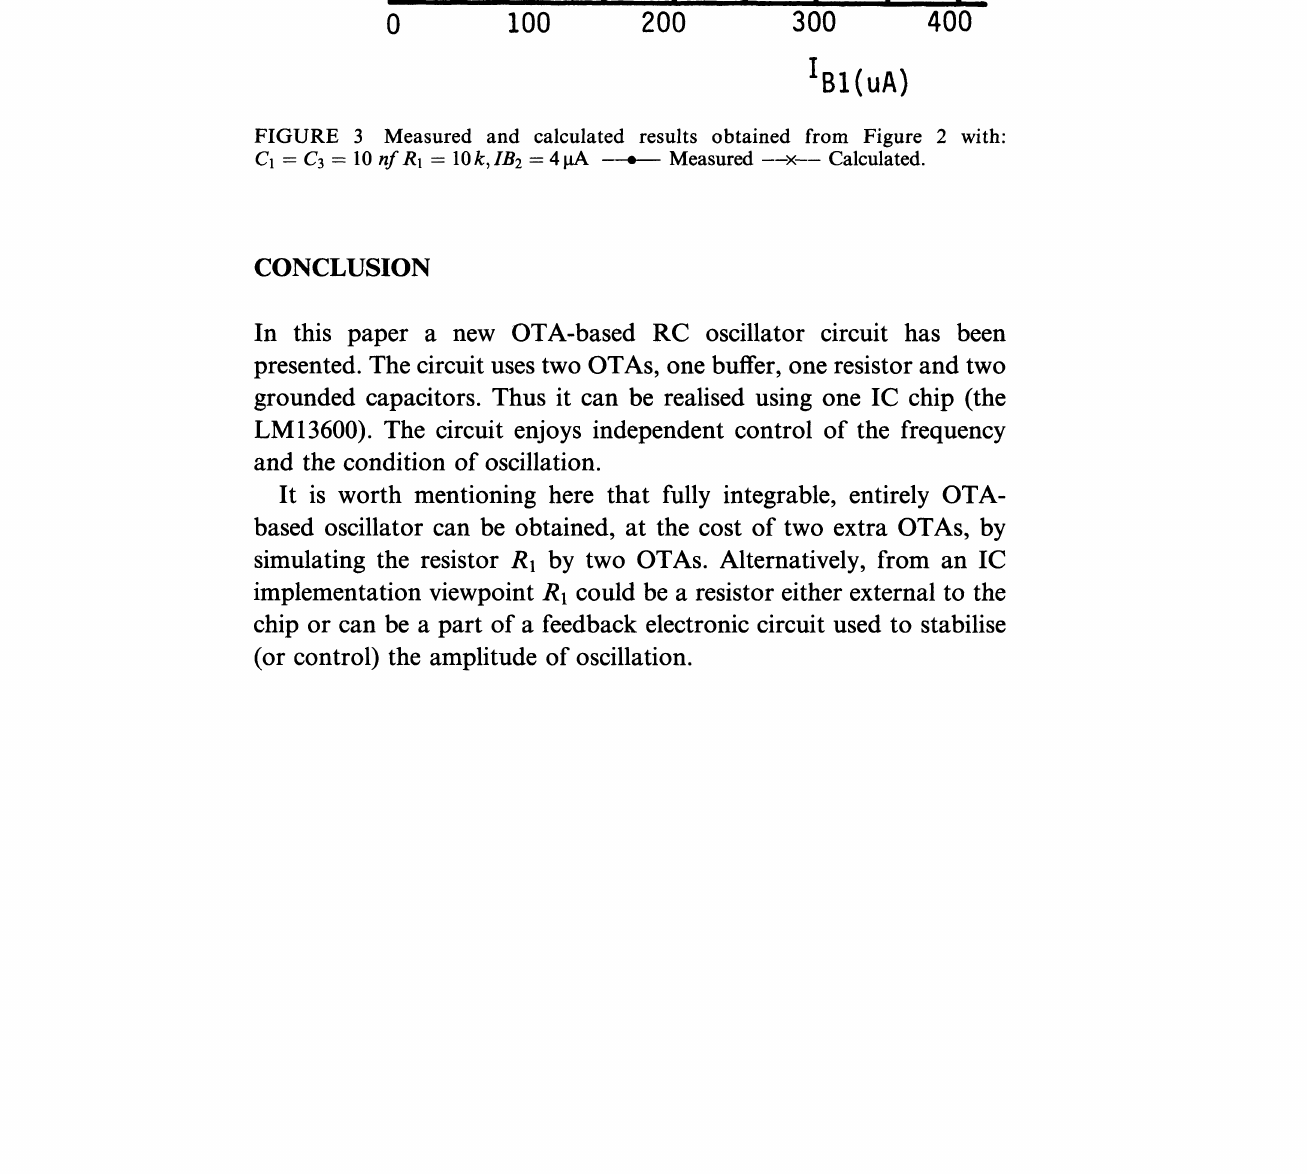
FIGURE 3 Measured and calculated results obtained from Figure 2 with: C1 Ca 10 nf R1 10 k, IB2 4 gA Measured --x--